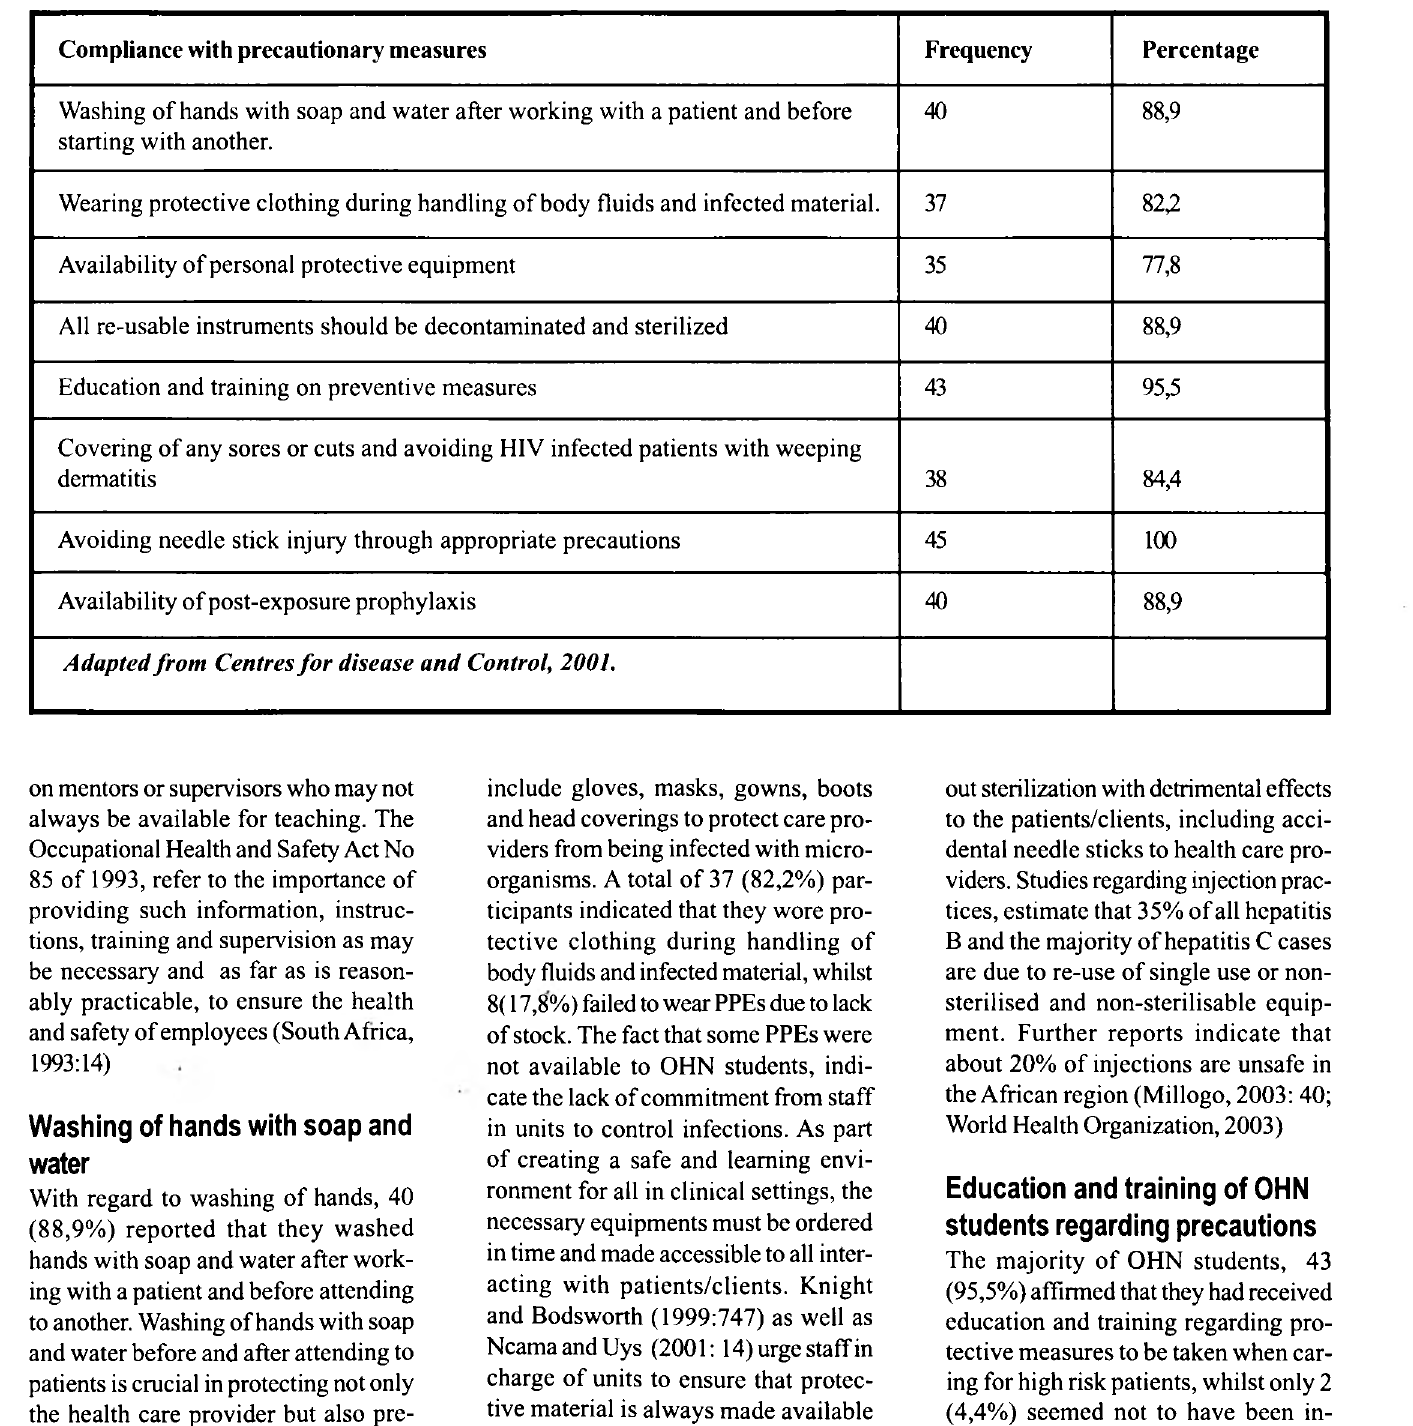
Table 2: Universal precautions used by OHN students